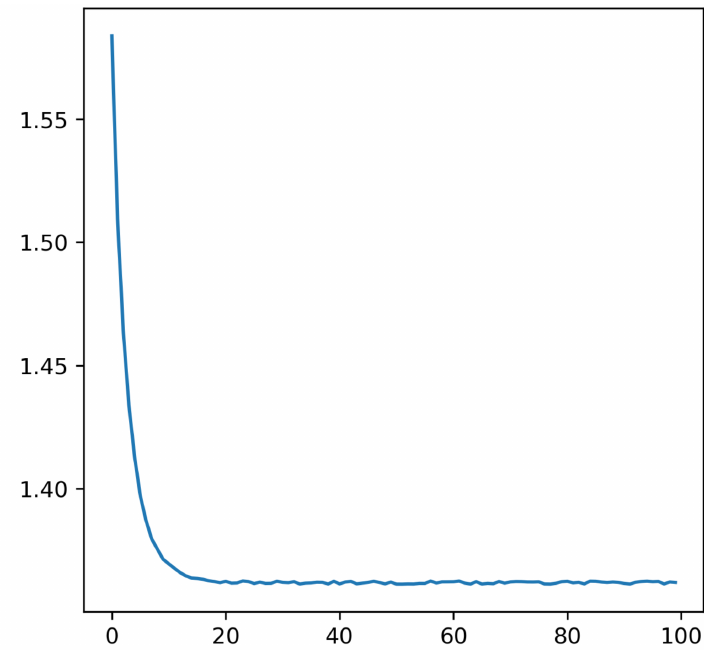
Figure 6. The loss function of the JigClu-based feature pre-training